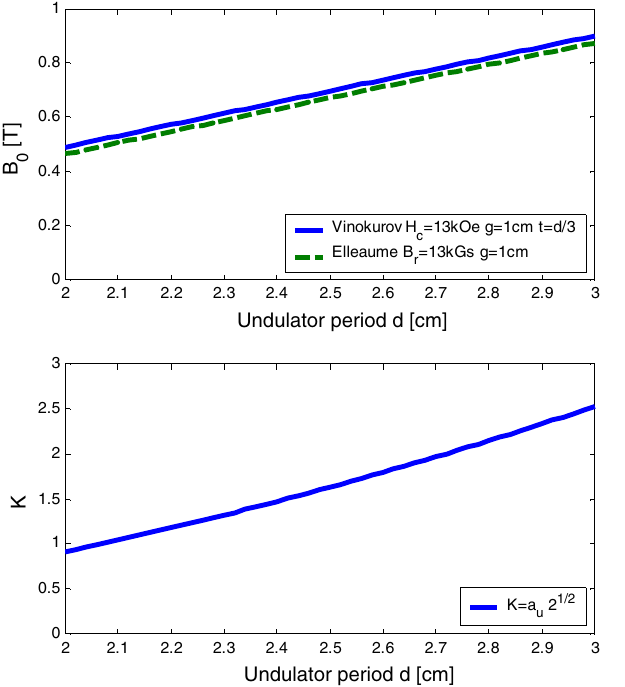
FIG. 1. Top: magnetic field amplitude B 0 for a planar hybrid undulator as a function of the undulator period d . t is the thickness of the permanent magnet blocks ( t (cid:2) d= 3 is a typical value) and g is the undulator gap. The results of the modified Halbach equation (Elleaume et al. [9]) are given for comparison. Bottom: the undulator parameter K .